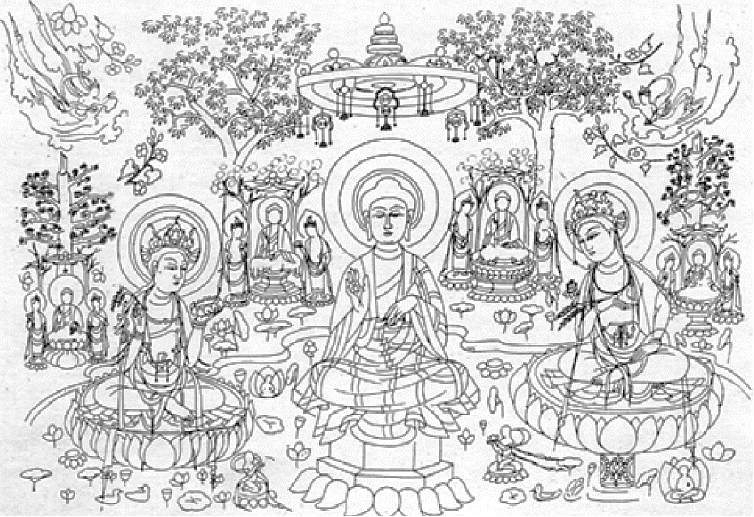
Figure 7. West Pure Land, Dunhuang Cave 393, Sui.